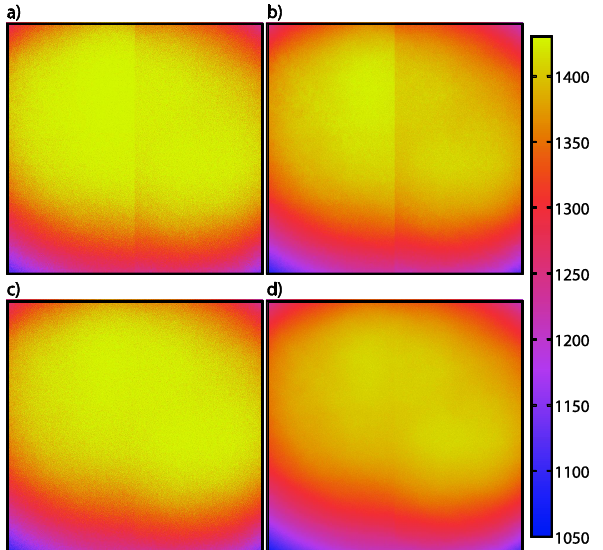
Figure 6. (a) Raw red image of smooth light source obtained by Fig. 6. (a) Raw red image of smooth light source obtained by sub-sampling only red 3 sub-sampling only red pixels from the color filter array; (b) average pixels from the color filter array; (b) average of ten red frames, including (a); (c),(d) 4 of ten red frames, including (a) ; (c , d) uniformity correction applied uniformity correction applied to (a),(b), respectively. 5 to (a , b) , respectively.